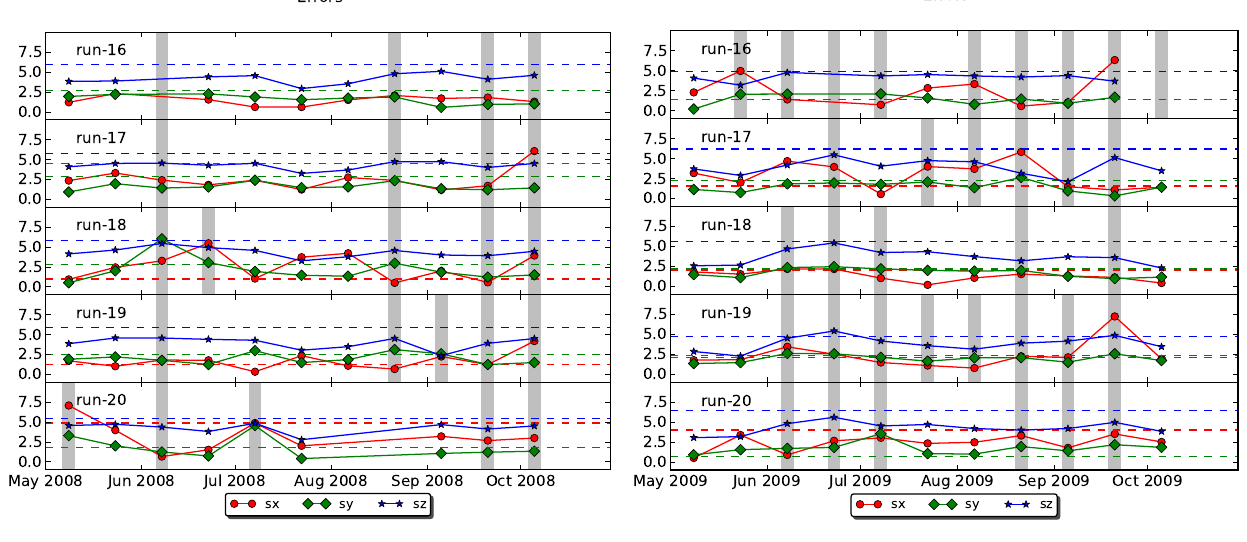
Fig. 7. Same as Fig. 5 but for estimated errors of station (sx,red), model (sy,green) and satellite